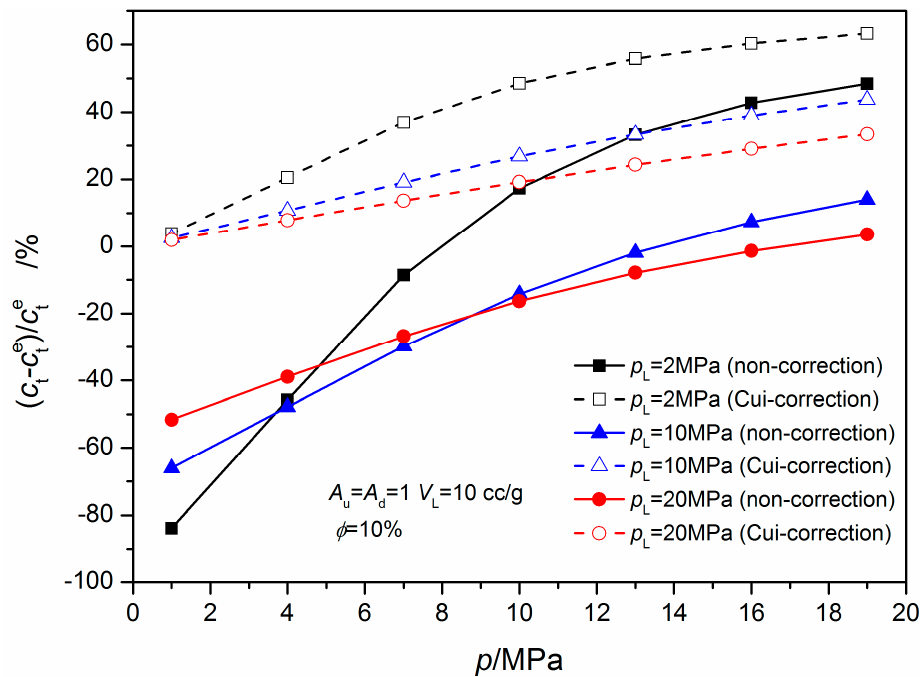
Figure 11. The influence of p L on the total compressibility.